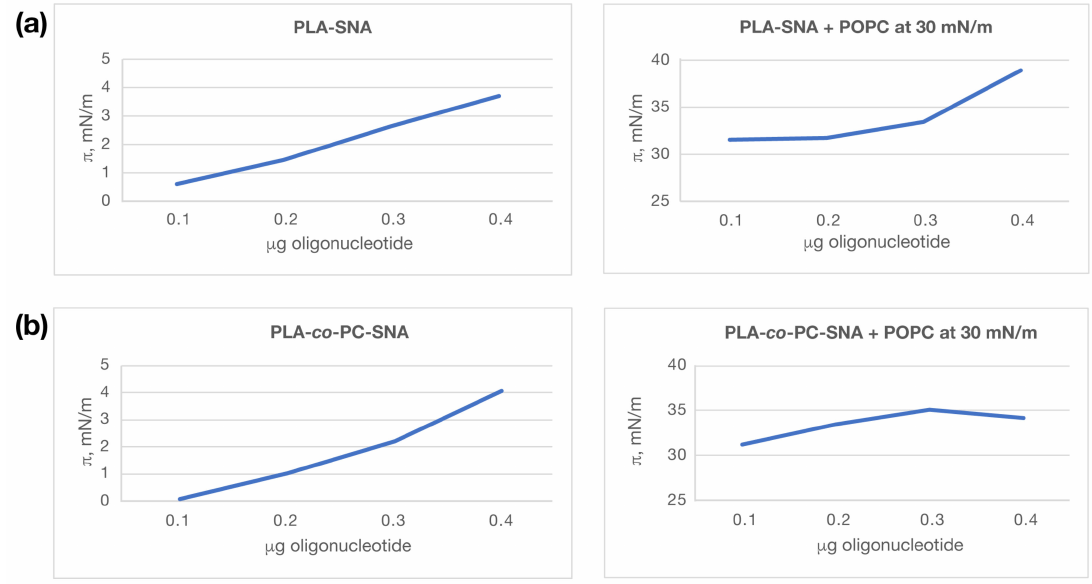
Figure 7. Adsorption π /C isotherms of: ( a ) PLA-SNA and ( b ) PLA- co -PC-SNA on 150 mM NaCl without and with